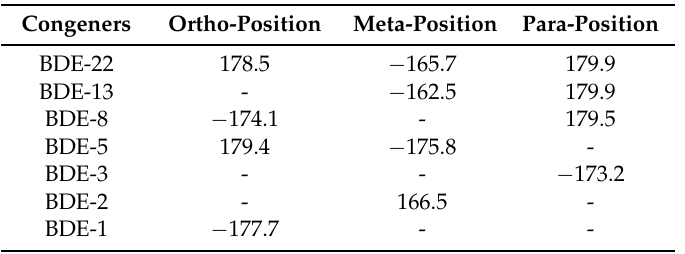
Table 6. The dihedral angles of C–Br bond for the selected anionic PBDEs at the B3LYP/6-311+G(d) level